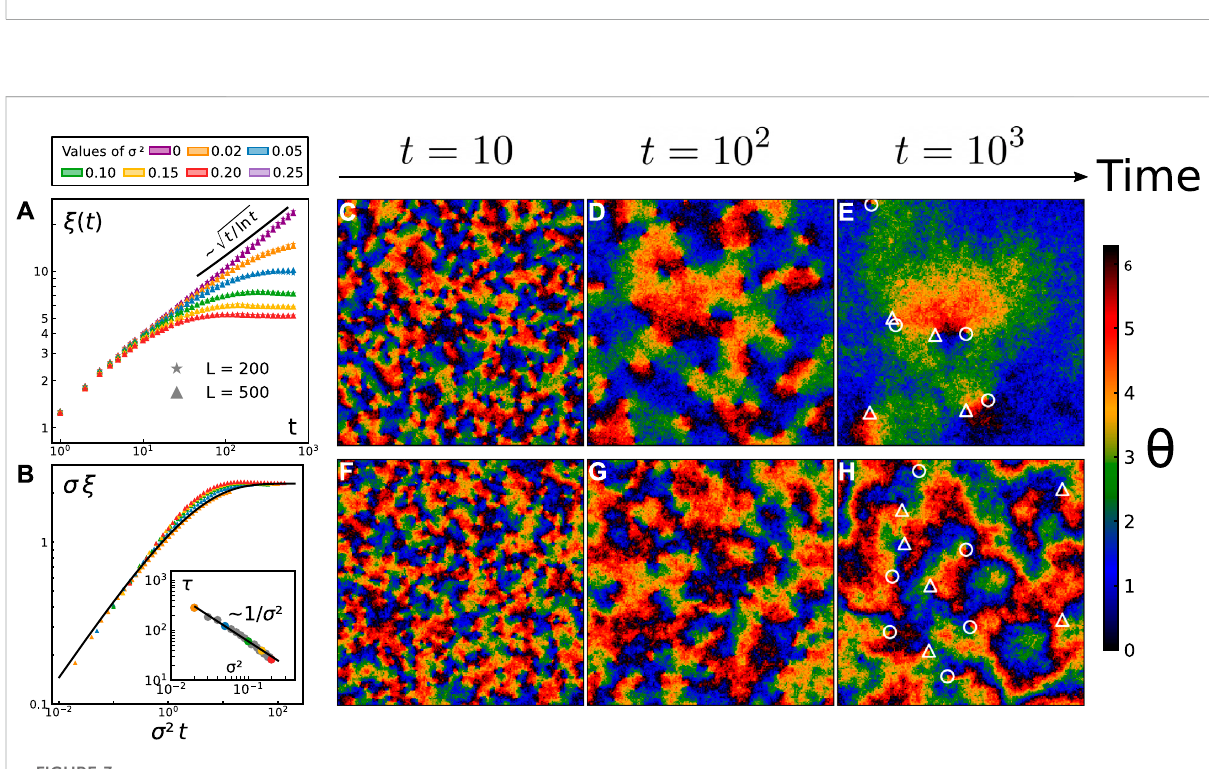
FIGURE 3 Time evolution of the characteristic length scale (A – B) illustrated by typical snapshots of a 200 × 200 system (C – H) . (A) Growth of the typical length scale ξ ( t ) for T = 0.4 and several σ , as indicated in the legend above (same colors as in Figures 2, 4); (B) the same data where ξ and t have been rescaled by σ and σ 2 , respectively. All curves collapse onto asingle master curve f ( x ) (cid:2) a ( 1 − exp (− b the transients time τ de fi ned in Eq. 9 against the self-spinning intensity. (C – D – E) Representative con fi gurations at different times showing the evolutionofthesystemafteraquench(for T =0.2and σ 2 =0).Thephaseofeachoscillatorisrepresentedbyacycliccolorscale.Inthelastpanelonly, vortices (anti-vortices) are represented by circles (triangles). (F – G – H) Representative con fi gurations at different times now for T = 0.2 and σ 2 =